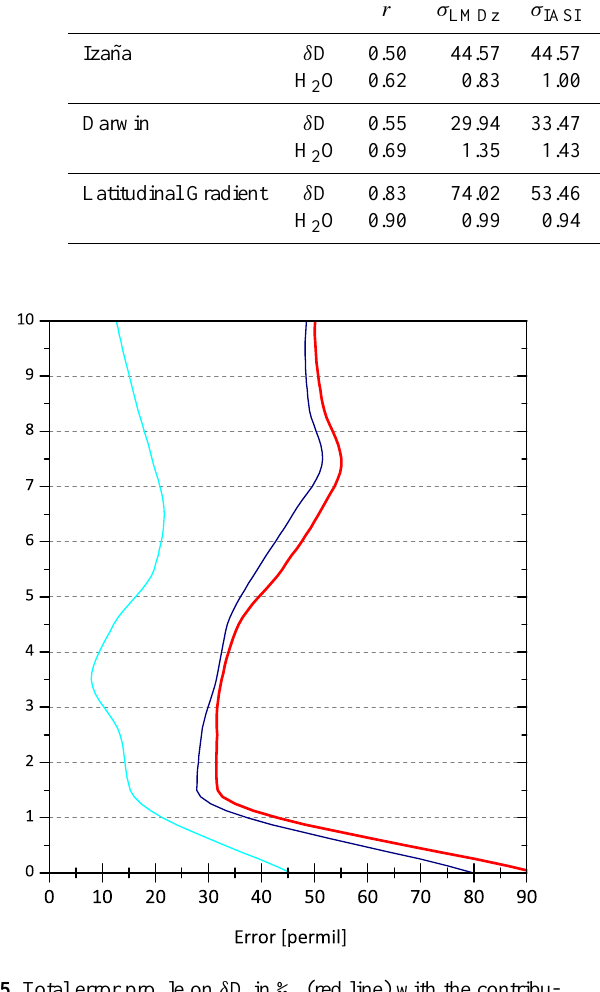
Fig. 5. Total error profile on δ D in ‰ (red line) with the contribu- tions due to the measurement noise (blue line) and to the uncertain- ties in the temperature profile (cyan